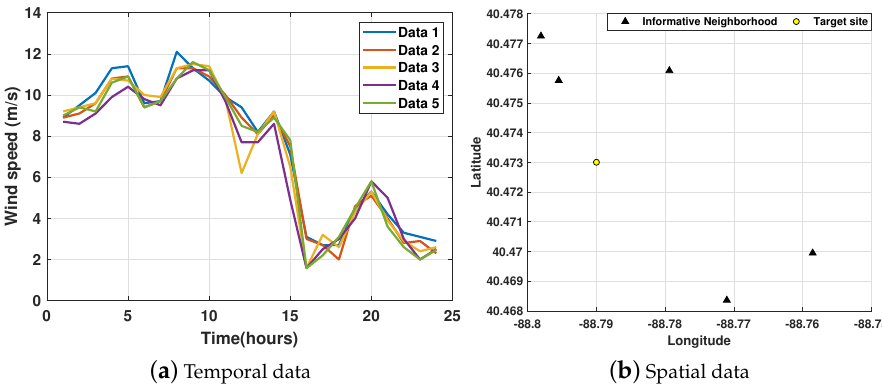
Figure 3. Spatio-temporal wind speed data. ( a ) depicts the wind speed data at measured points. ( b ) depicts the coordinates of the measured points and the target site.